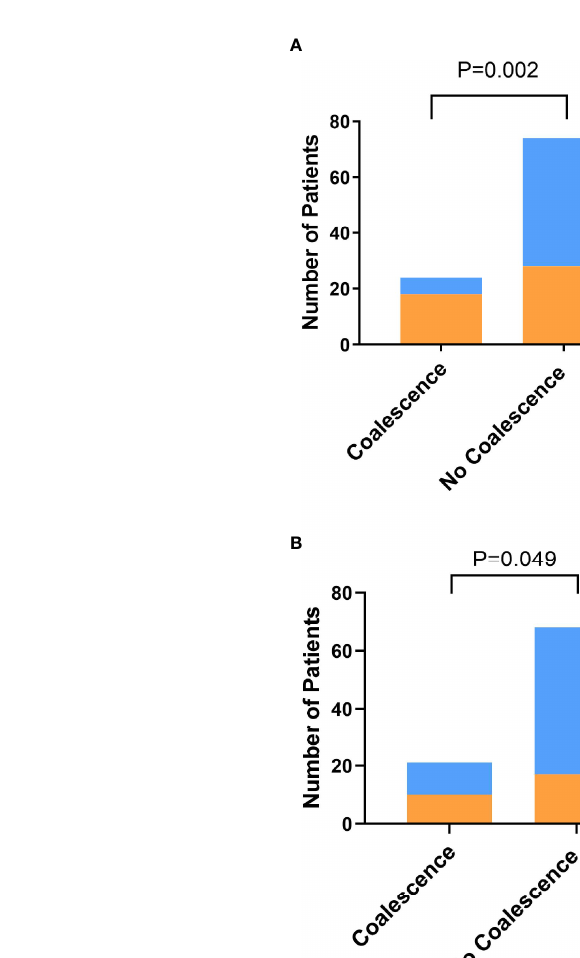
( Table 1 ) produced analogous results for cefepime (HR 2.81, 95% CI 1.16 – 6.90, P = 0.022), linezolid (HR 4.60, 95% CI 1.14 – 18.61, P = 0.032), meropenem (HR 6.72, 95% CI 2.08 – 21.76, P = 0.001), and metronidazole (HR 6.03, 95% CI 2.48-14.65,